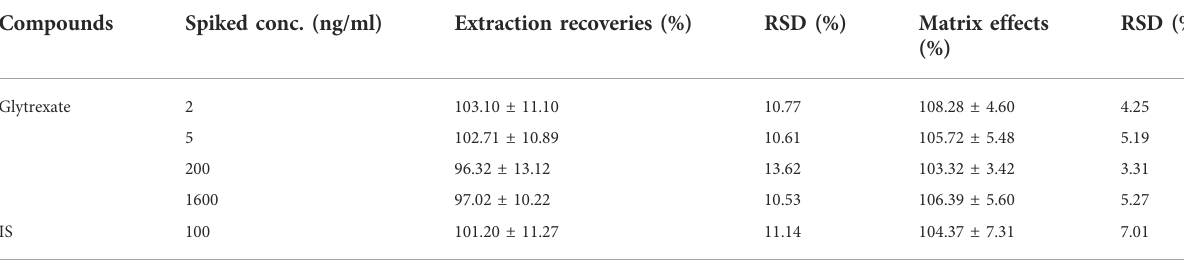
TABLE 2 Extraction recoveries and matrix effects of glytrexate and the IS in rat plasma ( n = 6). Compounds Spiked conc. (ng/ml)